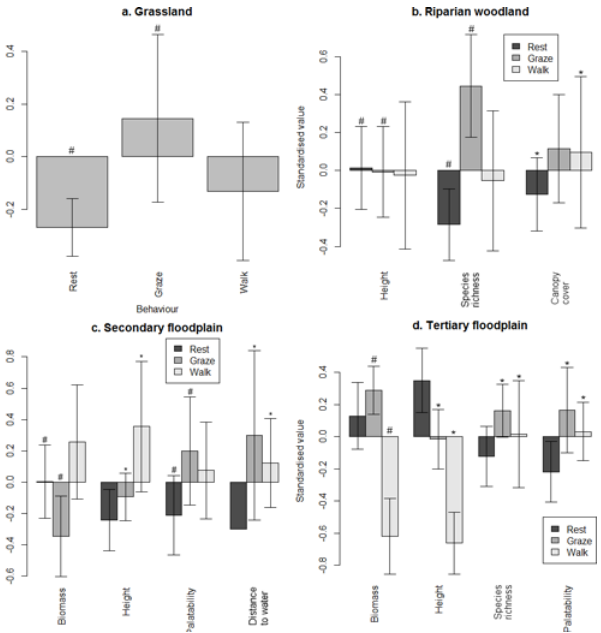
Fig 6. Variables discriminating between microhabitats used for different behaviours during the late flood season. Values marked with (#) and ( * ) were significantly and not significantly different from each other,